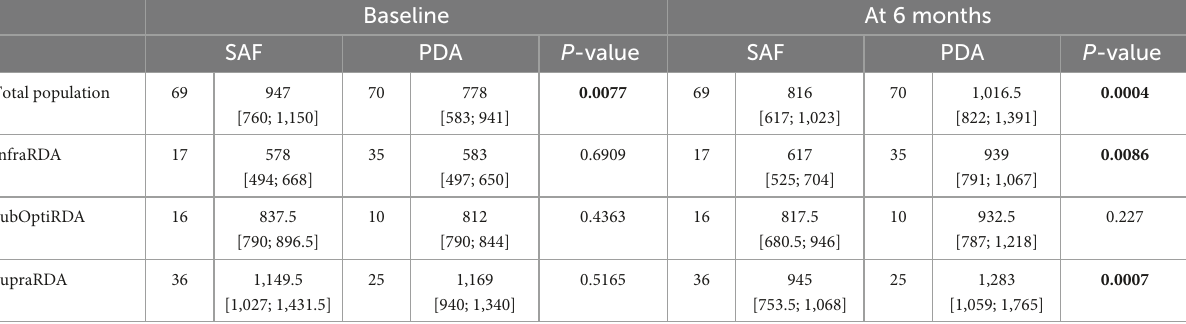
TABLE 2 Calcium intake of total and stratified baseline population in PDA and SAF groups and evolution of calcium intake at 6 months in each